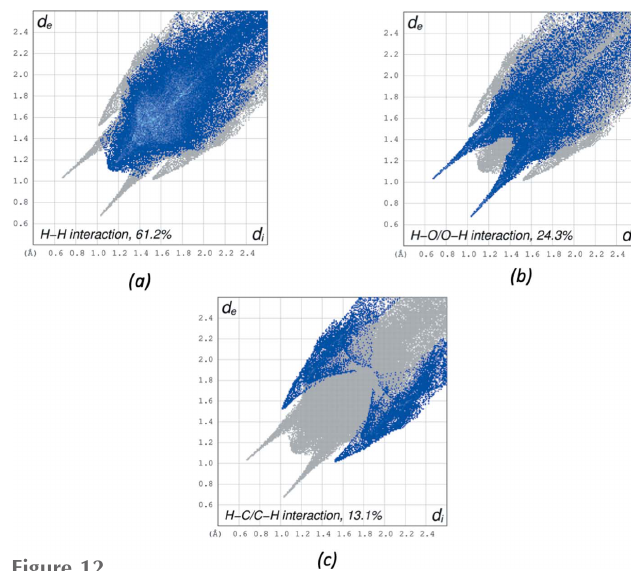
Figure 12 The two-dimensional fingerprint plots for III delineated into ( a ) H (cid:5)(cid:5)(cid:5)